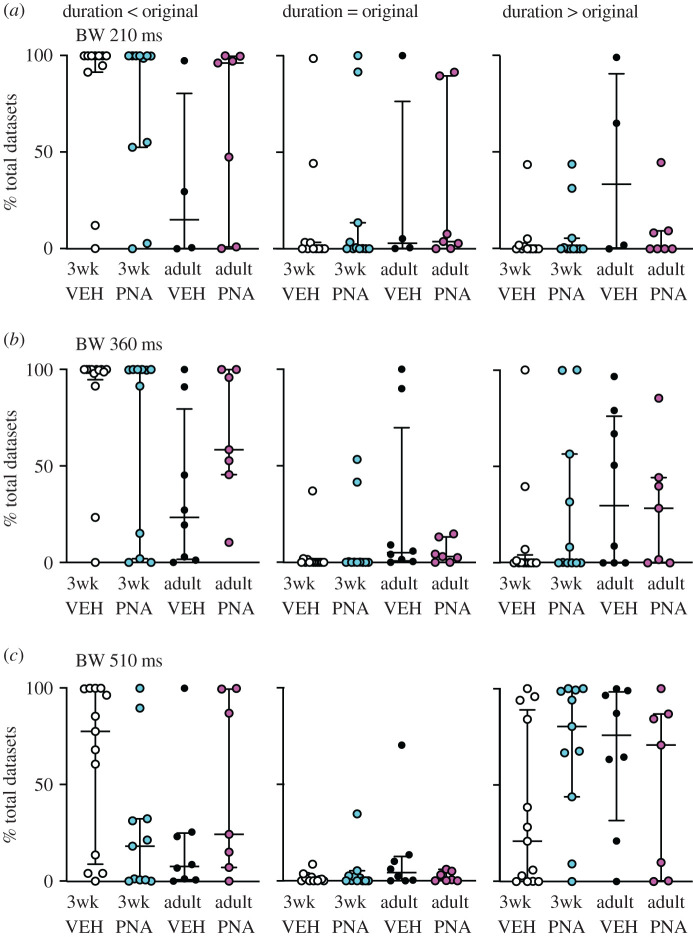
Burst duration is longer in GnRH neurons in the physiologic range of burst windows (BW). Each dot shows the percentage of total datasets from an individual cell with a burst duration that is less than (left), equal to (centre) or greater than (right) the original data's value for burst windows of (a) 210 ms, (b) 360 ms and (c) 510 ms. Graphs show individual values, median and interquartile range.